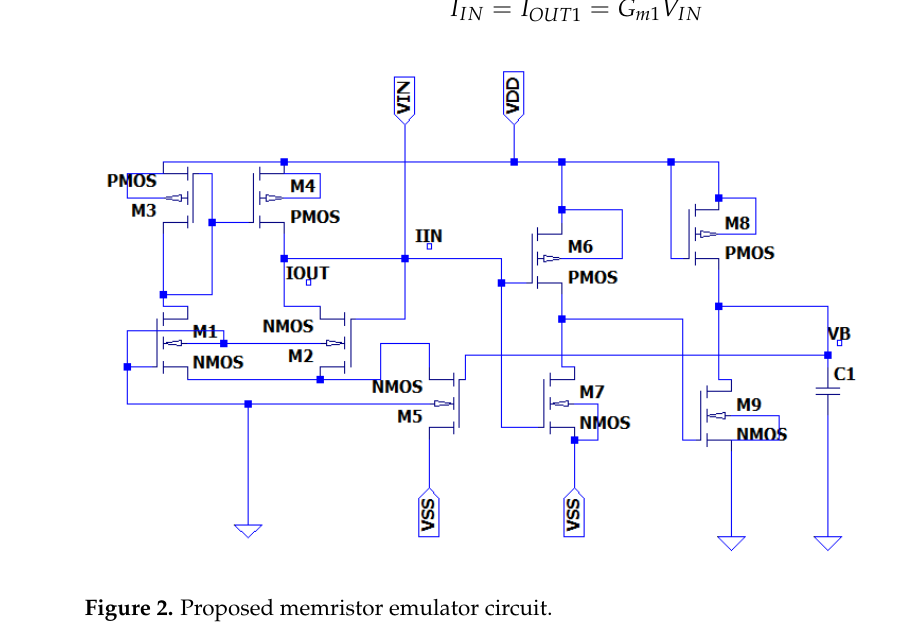
Figure 2. Proposed memristor emulator